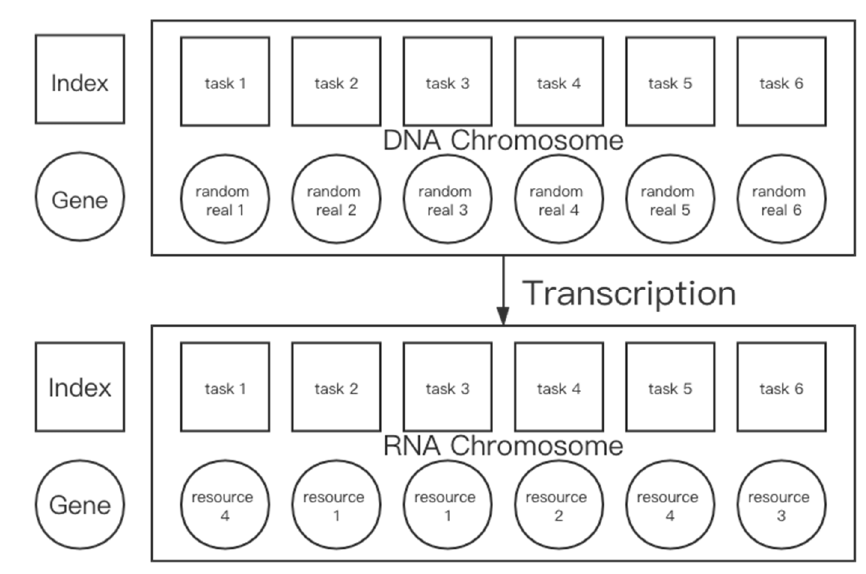
Figure 5. DNA Transcription RNA.